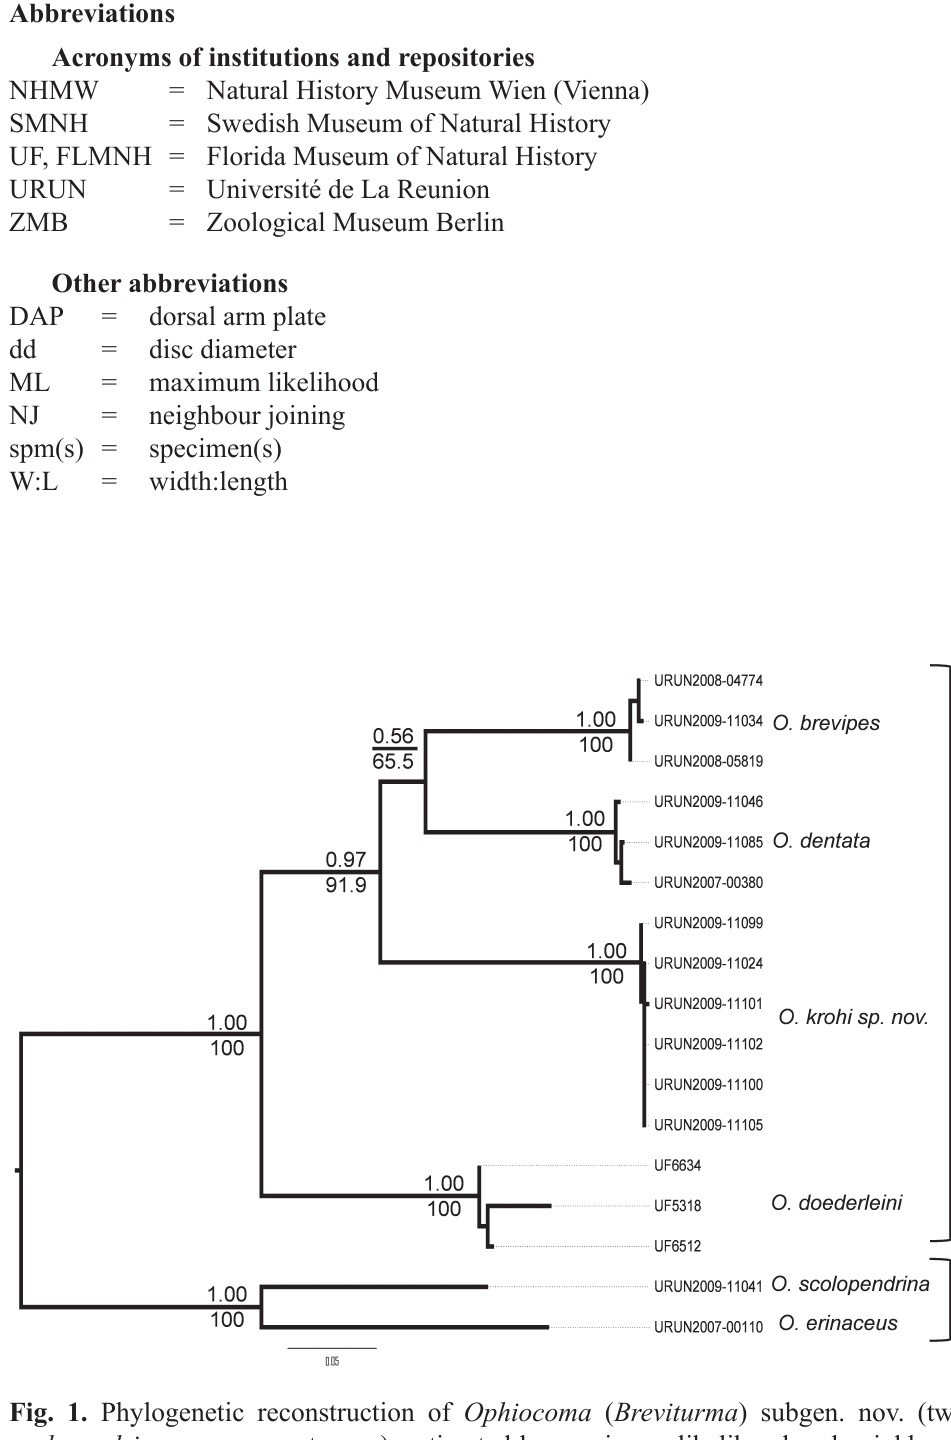
Fig. 1. Phylogenetic reconstruction of Ophiocoma ( Breviturma ) subgen. nov. (two species of the scolopendrina group as outgroup), estimated by maximum likelihood and neighbour-joining analysis of concatenated sequences of the mitochondrial cytochrome c oxidase subunit I and rDNA 16S (in total 1125 bp). Values at branches indicate bootstrap values for maximum likelihood (above branches) and neighbour-joining (below branches). Specimen codes are resolved in the Supplementary